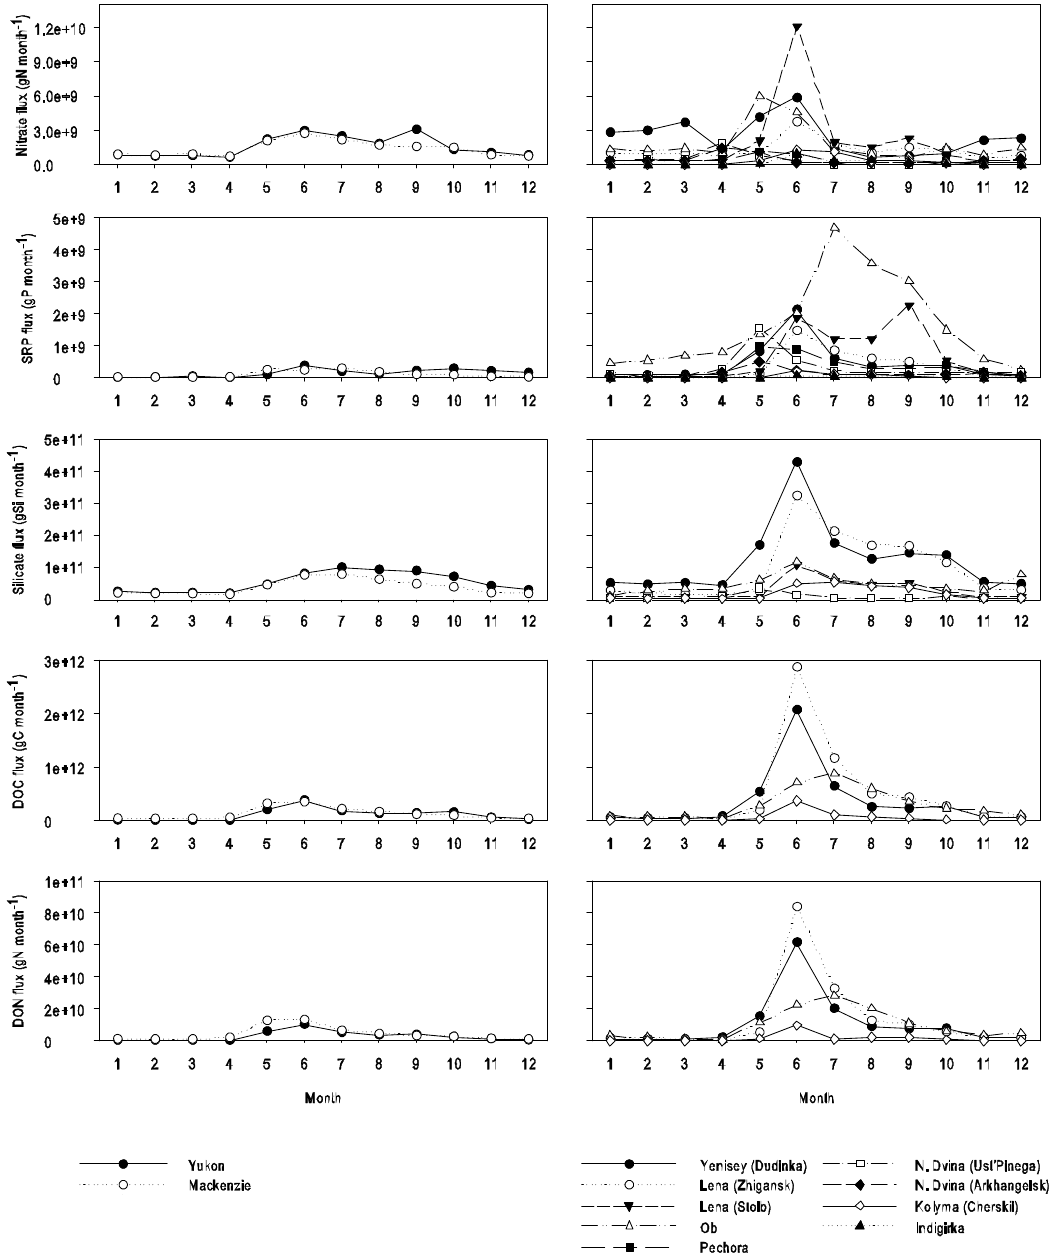
Fig. 3. Monthly flux estimates of riverine nitrate, SRP, silicate, DOC and DON for the North American and Eurasian rivers.